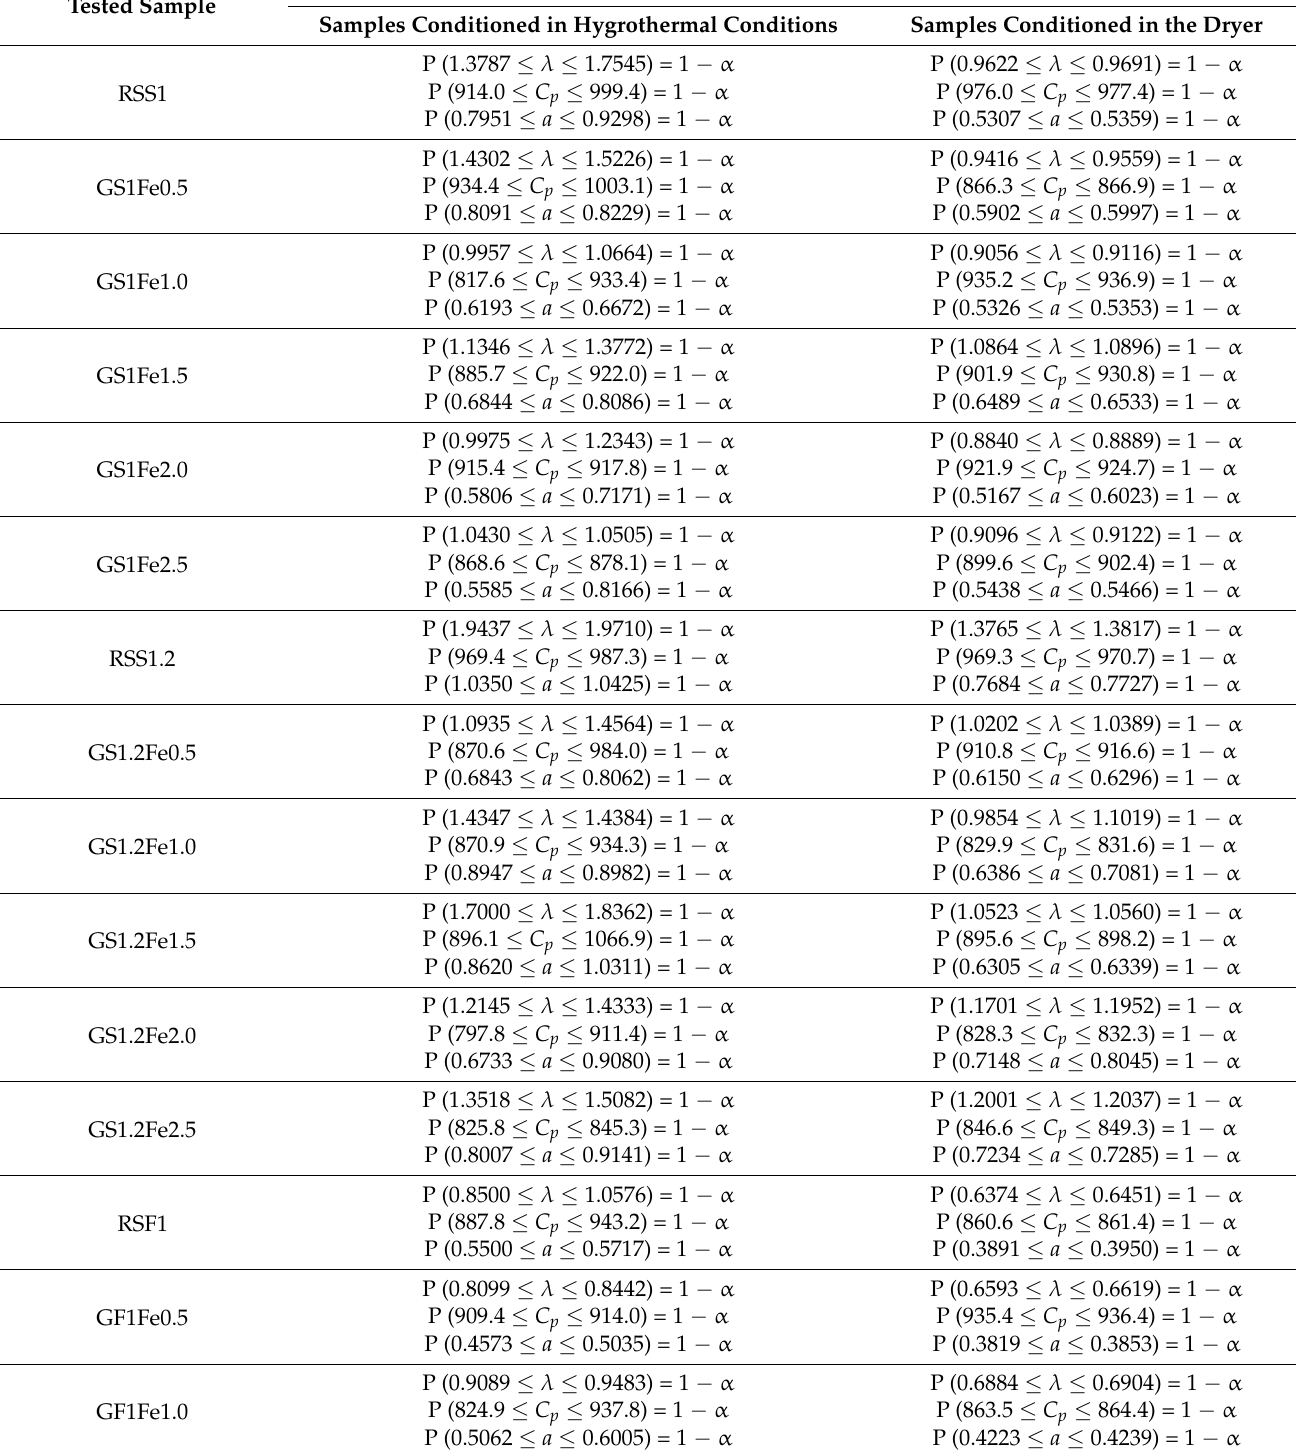
Table 3. Calculated confidence intervals of the measured thermal properties of the modified geopoly- meric